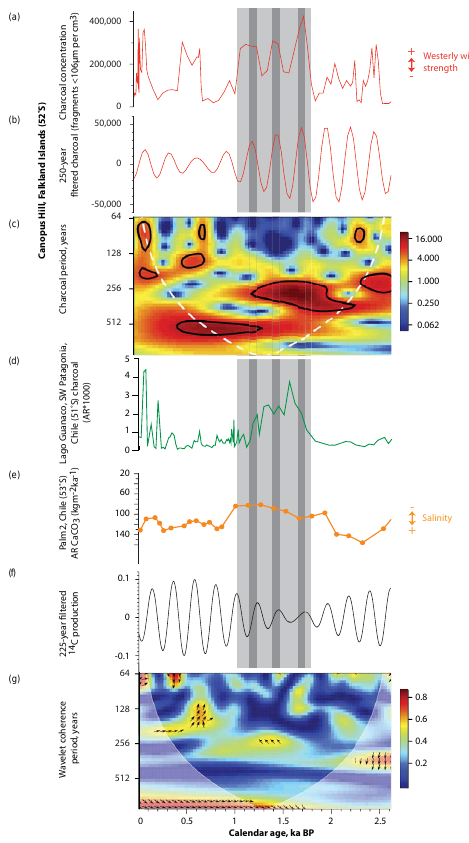
Figure 7. Charcoal concentration (<106µm) (a) , Gaussian-filtered charcoal in the 250-year band (250 ± 25 years − 1 ) (b) , and wavelet analysis of charcoal concentration (c) from Canopus Hill, Port Stan- ley Airport (52 ◦ S). Solid black line in wavelet denotes 95% con- fidence in periodicity; white dashed line denotes cone of influ- ence. (d) Charcoal concentration data from Laguna Guanaco, Chile (51 ◦ S) (Moreno et al., 2009); (e) the biogenic carbonate accumu- lation rate (AR) from Palm2, Chile (53 ◦ S). Gaussian-filtered 14 C in the 225-year band (225 ± 22.5years − 1 ) are plotted in (f) , and wavelet coherence between the 30-year sampled charcoal and 14 C production in (g) ; white dashed line denotes cone of influence; ar- rows pointing up indicate that 14 C production (solar) leads Falkland Islands charcoal (proxy of Southern Hemisphere westerly strength). The dark grey columns define peaks in charcoal 250-year periodic- ity lagging minima in 14 C production rate (high solar irradiance); the light grey area describes the period of pervasively stronger winds across the South Atlantic 2000 to